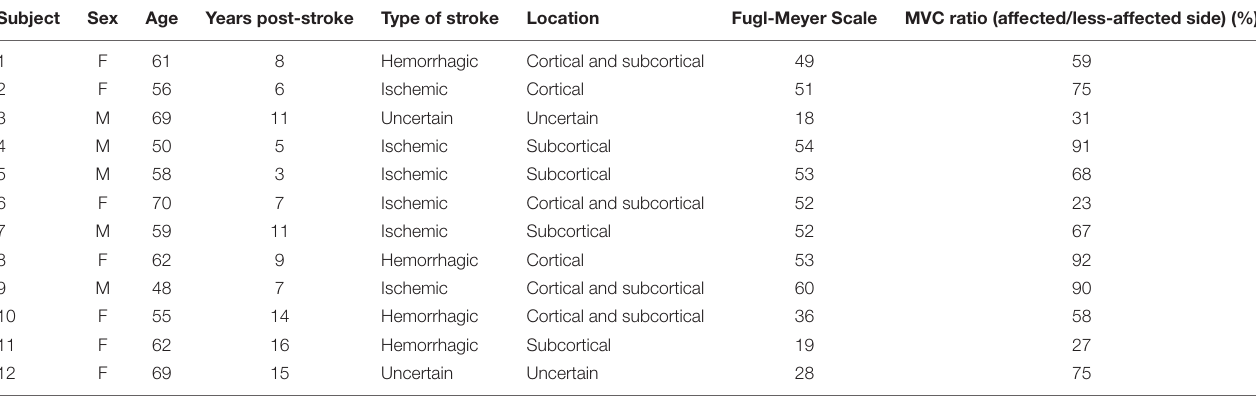
TABLE 1 | Clinical details on each stroke survivor, including time since stroke, location of brain lesion, the Upper-Extremity Fugl-Meyer Scale (FMUE) for the affected side and the MVC force ratio on the affected and less-affected